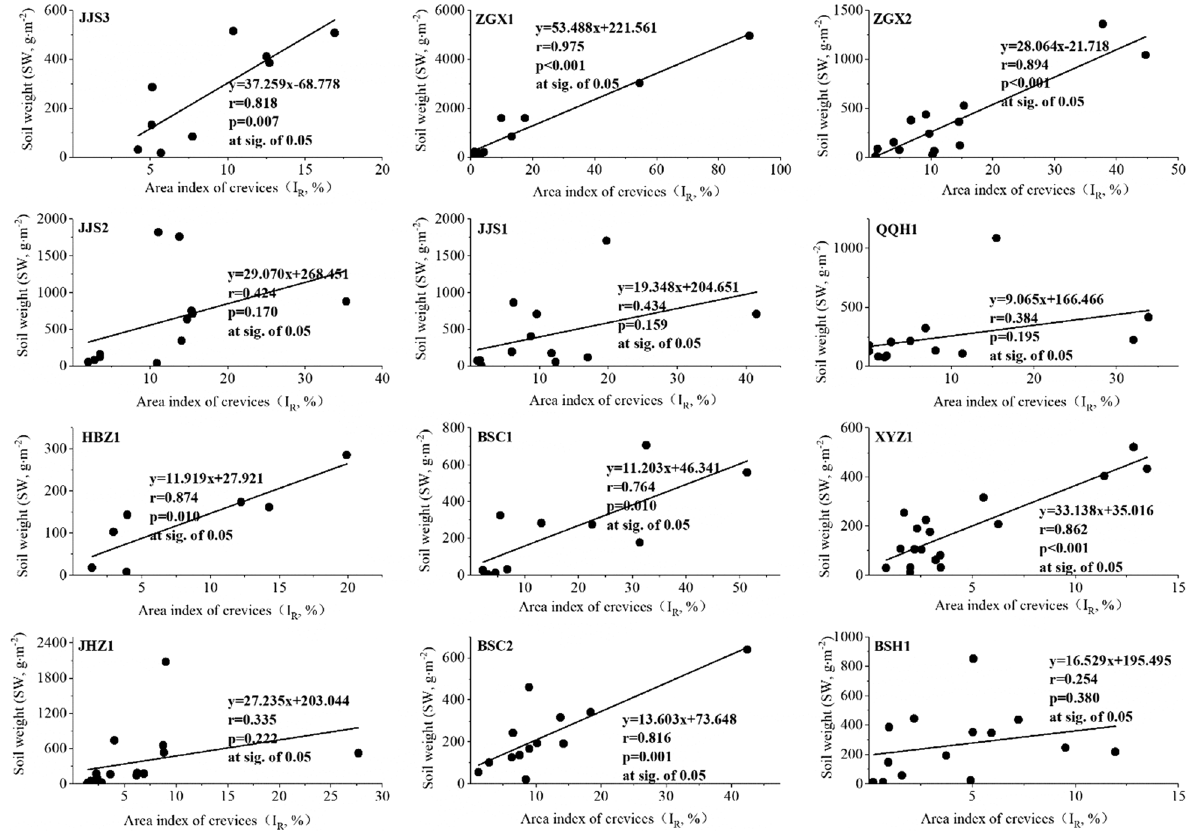
Fig. 7 Relationships between soil weight and area index of crevices at 13 sampling sites